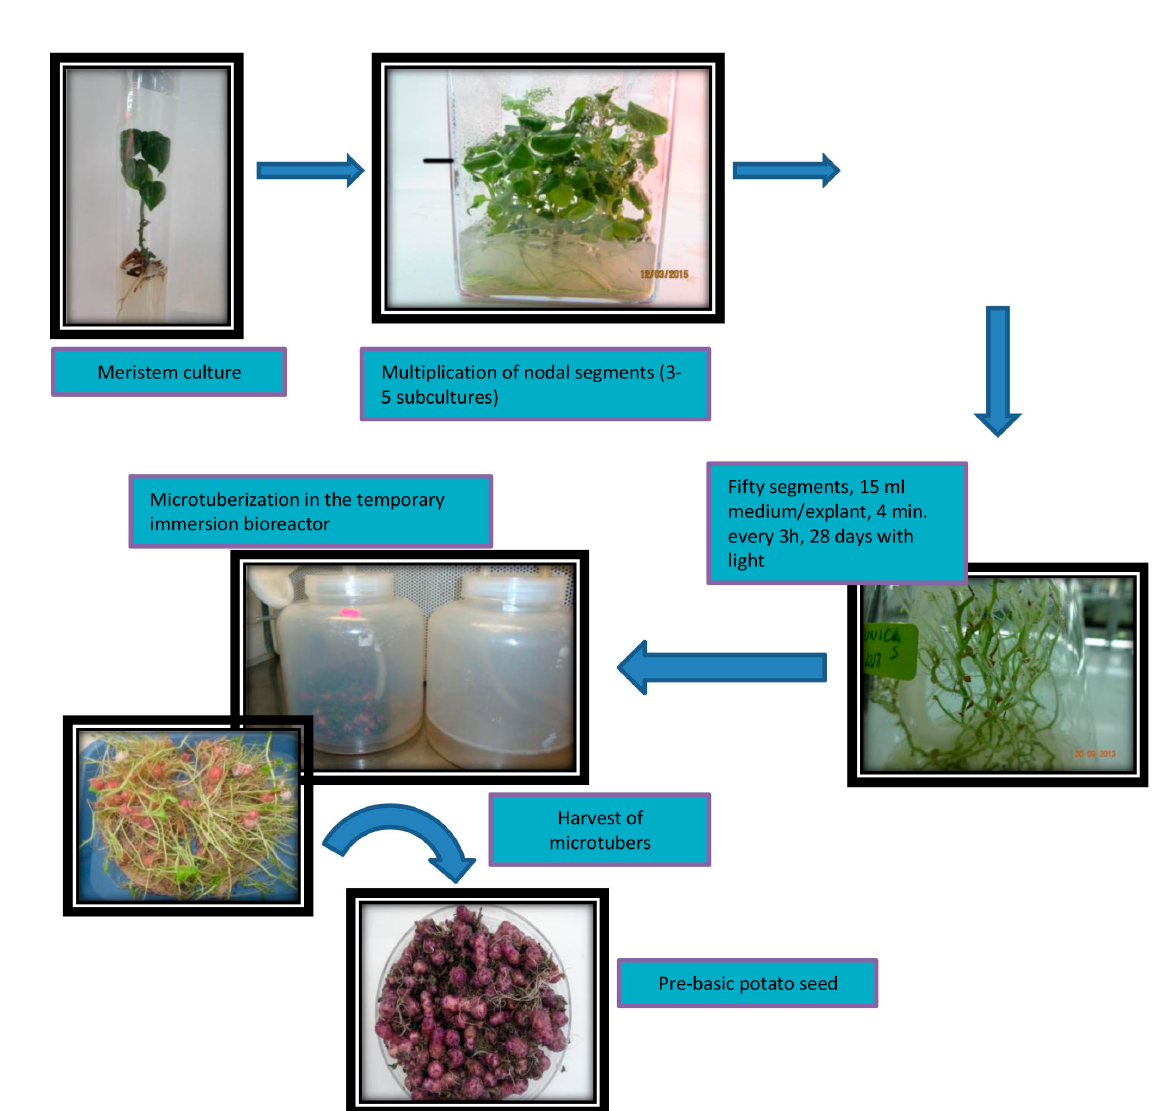
Figure 1. Protocol for the production of potato microtubers using temporary immersion bioreactors (TIB) a total of 250 and 270 microtubers, respectively. On the other hand, “Papa 3” produced only 100 microtubers